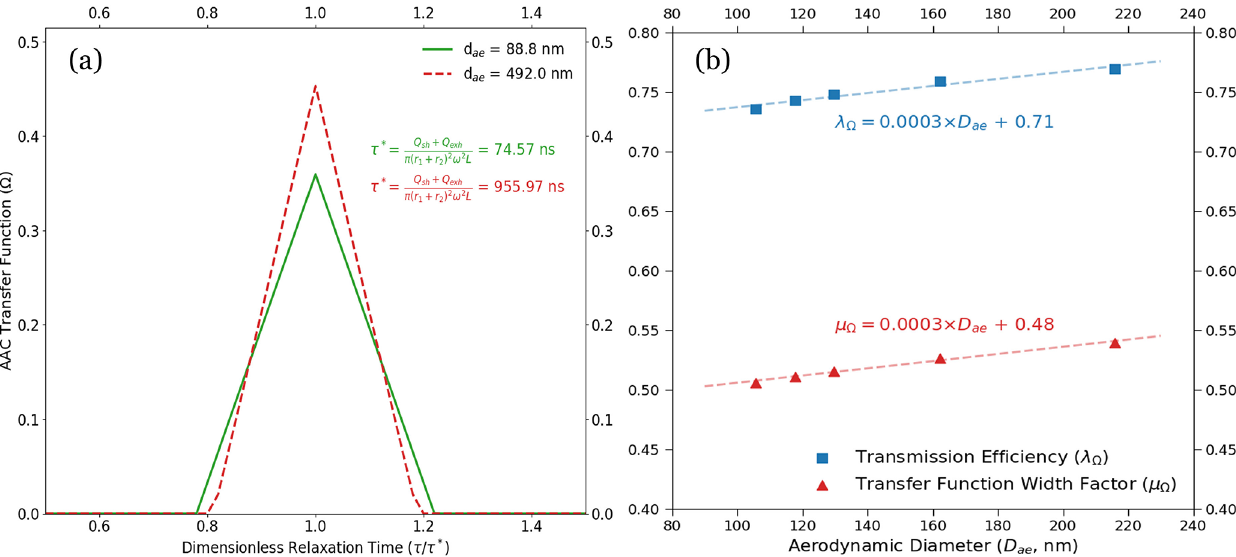
Figure 5. (a) ND–B–NI transfer functions for low-flow measurement conditions from the AAC-based setup are shown. The transfer functions are plotted with respect to dimensionless relaxation time. The lower and upper aerodynamic diameter limits for the measurements are 90 and 392.3nm, respectively. The corresponding relaxation times are highlighted for the aerodynamic diameter set points. The resolution increases, and hence the measurement uncertainties, decrease with an increase in the particle aerodynamic diameter. (b) The size-dependent transmission efficiency ( λ (cid:127) , blue) and transfer function width factor ( µ (cid:127) , red) are shown above. The marked points on the plot correspond to λ (cid:127) and µ (cid:127) computed at the dry activation diameters at the set instrument supersaturations used in this study (between 0.2% and 0.5%). As a general trend, both the transfer function parameters increase with the increase in aerodynamic diameter. This results in an increase in the AAC transfer function resolution and a decrease in the size-related uncertainty with an increase in aerodynamic diameter (that is, the particle relaxation time). The plot also shows that the transfer function width factor is slightly more sensitive to the increase in the aerodynamic diameter, which can be followed by comparing the slopes of the linear fits of the transmission efficiency and width factor relative to the aerodynamic